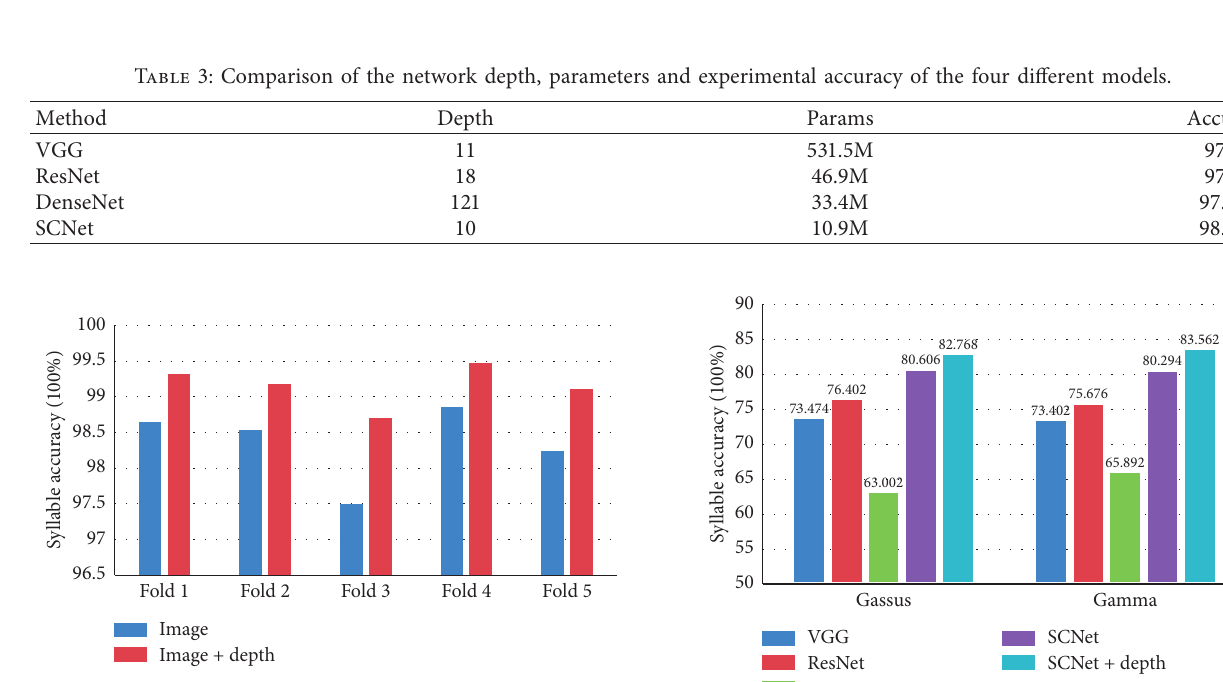
Figure 7: Convergence depth information and comparison of image-only results. Figure 8: Robustness test of several different dynamic noise